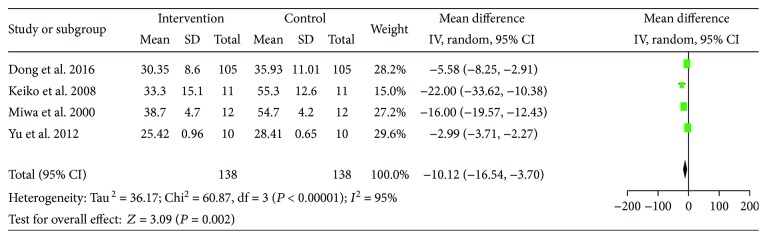
Forest plot for FAT%.